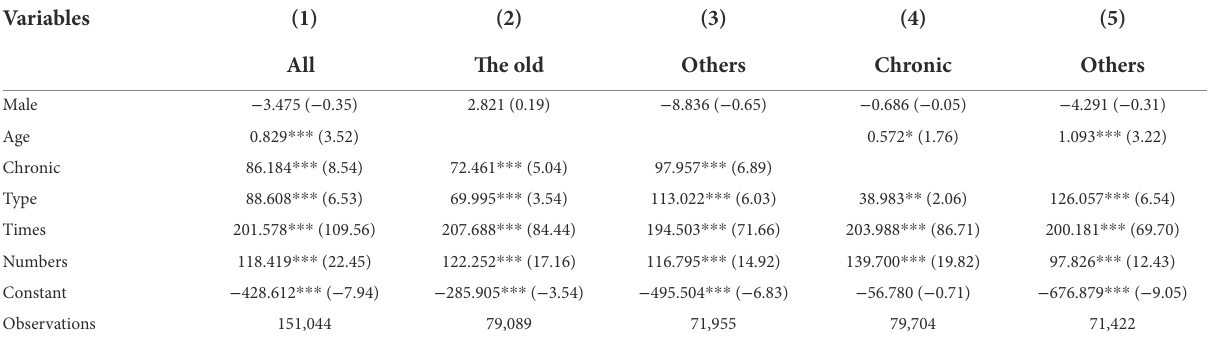
TABLE 5 Regression results of contracted samples grouped by age and chronic